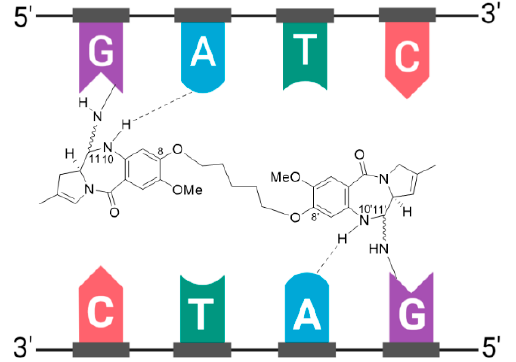
Figure 15. Schematic showing binding of the PBD dimer, SG3199, to the minor groove of DNA. The N2 of guanine binds the electrophilic C11 position on the PBD dimer. N2 of guanine binds the electrophilic C11 position on the PBD